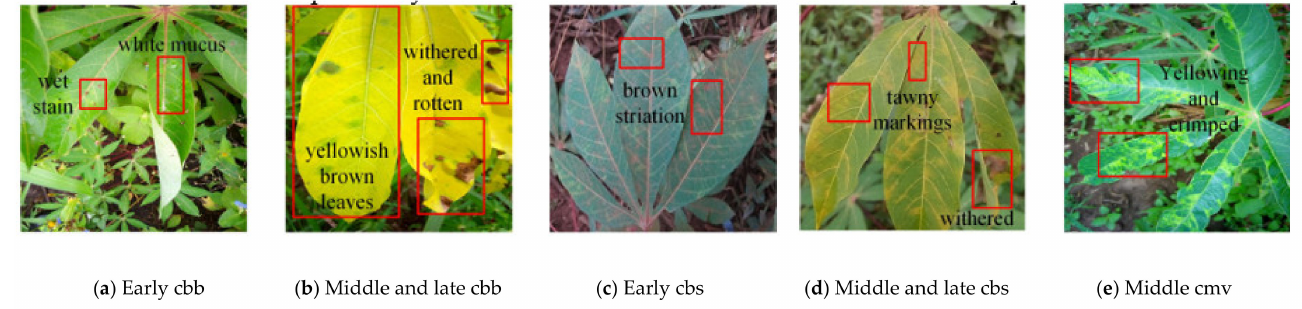
Figure 8. Comparisons of symptoms of different diseased cassava leaves at different stages. cbb, cbs and cmv are the abbreviations of cassava bacterial blight, cassava brown streak, and cassava mosaic virus.